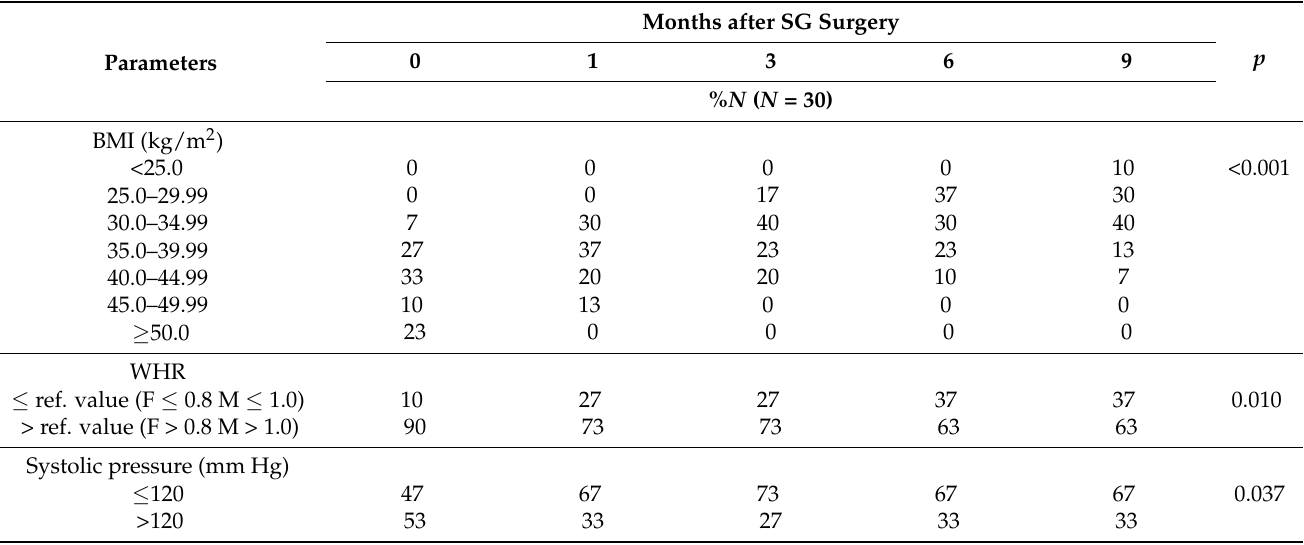
Table 4. Evaluation of anthropometric measurements and blood pressure in relation to reference values in patients within 9 months of